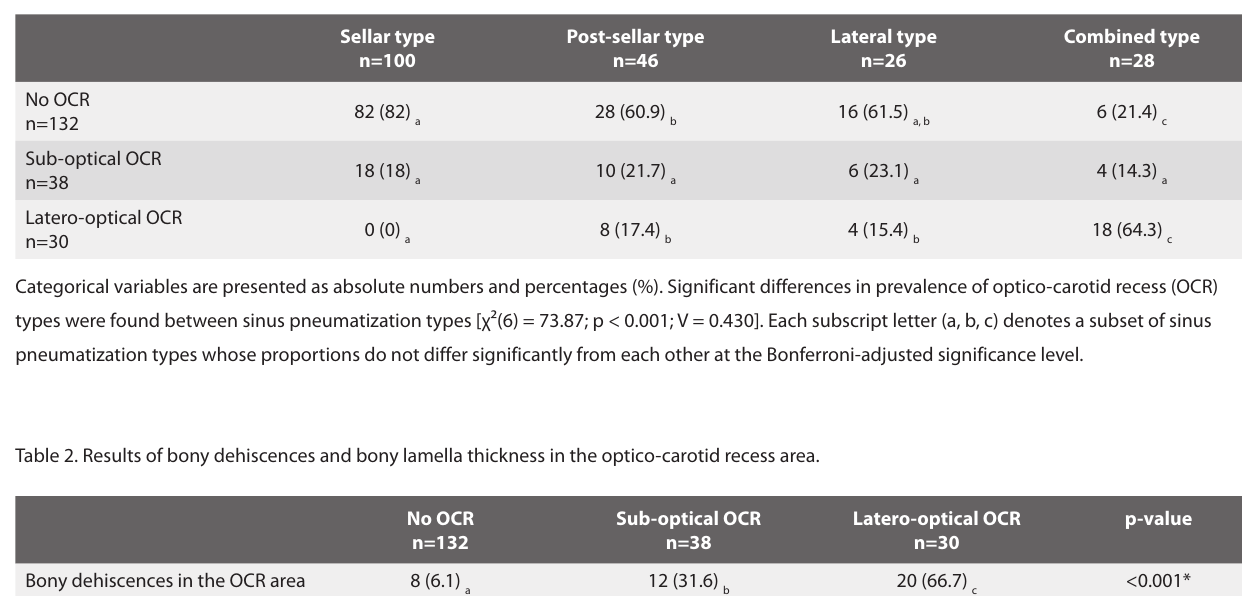
Table 2. Results of bony dehiscences and bony lamella thickness in the optico-carotid recess